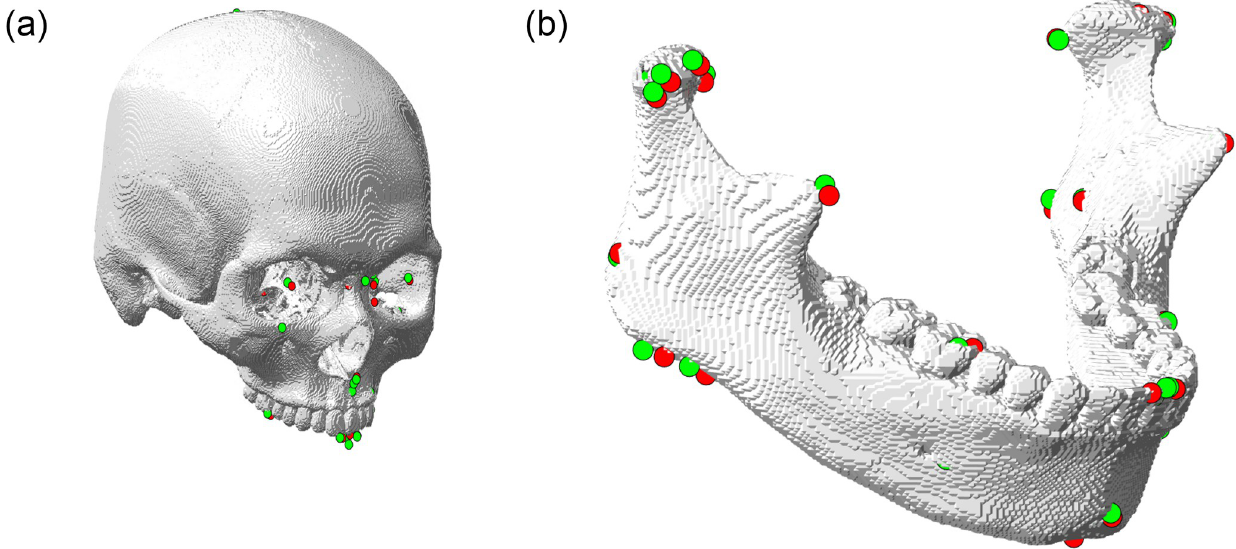
Fig 8. Qualitative evaluation of detection for (a) cranial landmarks and (b) mandibular landmarks. The red and green dots denote the ground truth and detected output landmarks